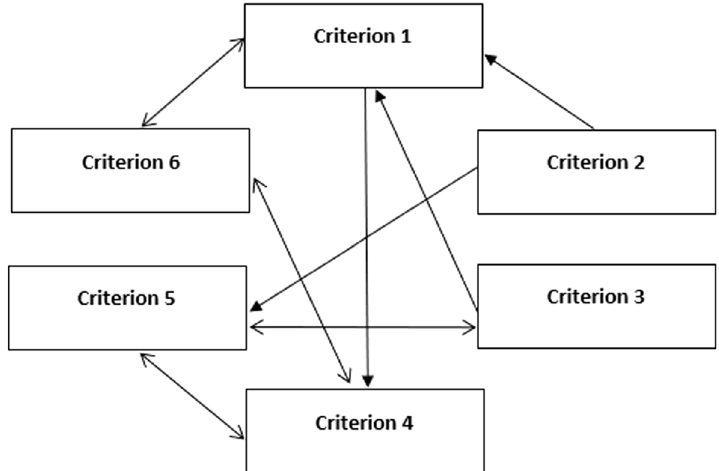
Fig. 6 Impact-relation map for the